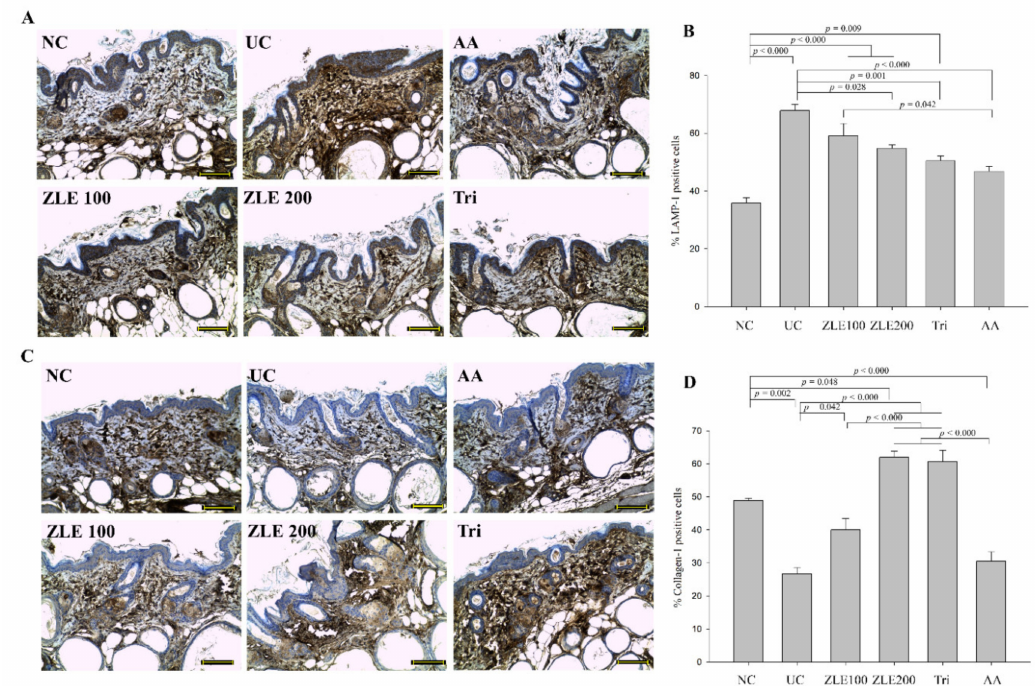
Figure 11. E ff ects of enzyme-treated Z. latifolia extract (ZLE) and tricin on the localization of LAMP-1 and collagen-1 in the UVA-irradiated dermis. ( A ): Representative IHC images of LAMP-1 in the skin sections (brown color). ( B ): Quantification of LAMP-1 positive cells (%). ( C ): Representative IHC images of collagen-1 in the skin sections (brown color). ( D ): Quantification of collagen-1 positive cells (%). The scale bar, located in the lower right of each image, is 0.1 mm, and the sections were obtained at 200 × magnification. Data are expressed as the mean ± SE. The p values are determined by ANOVA and Tukey’s HSD